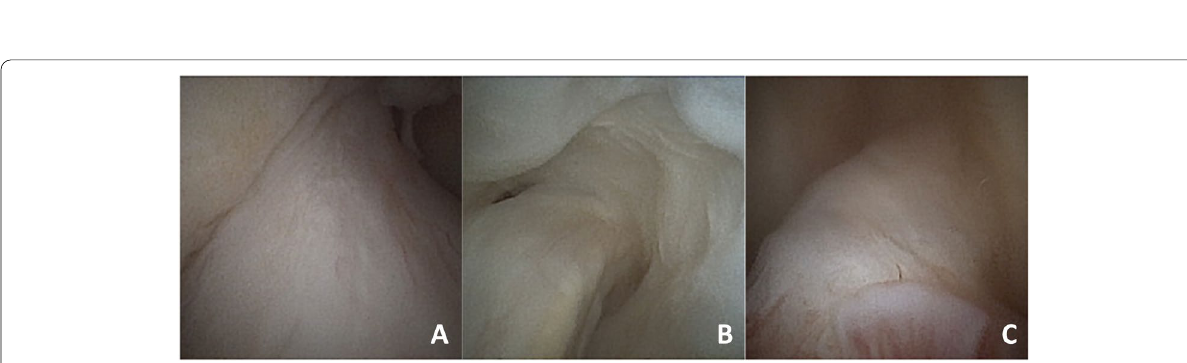
Fig. 2 A , B , C Good appearance of synovial coverage of the repaired ACL with in-office needle